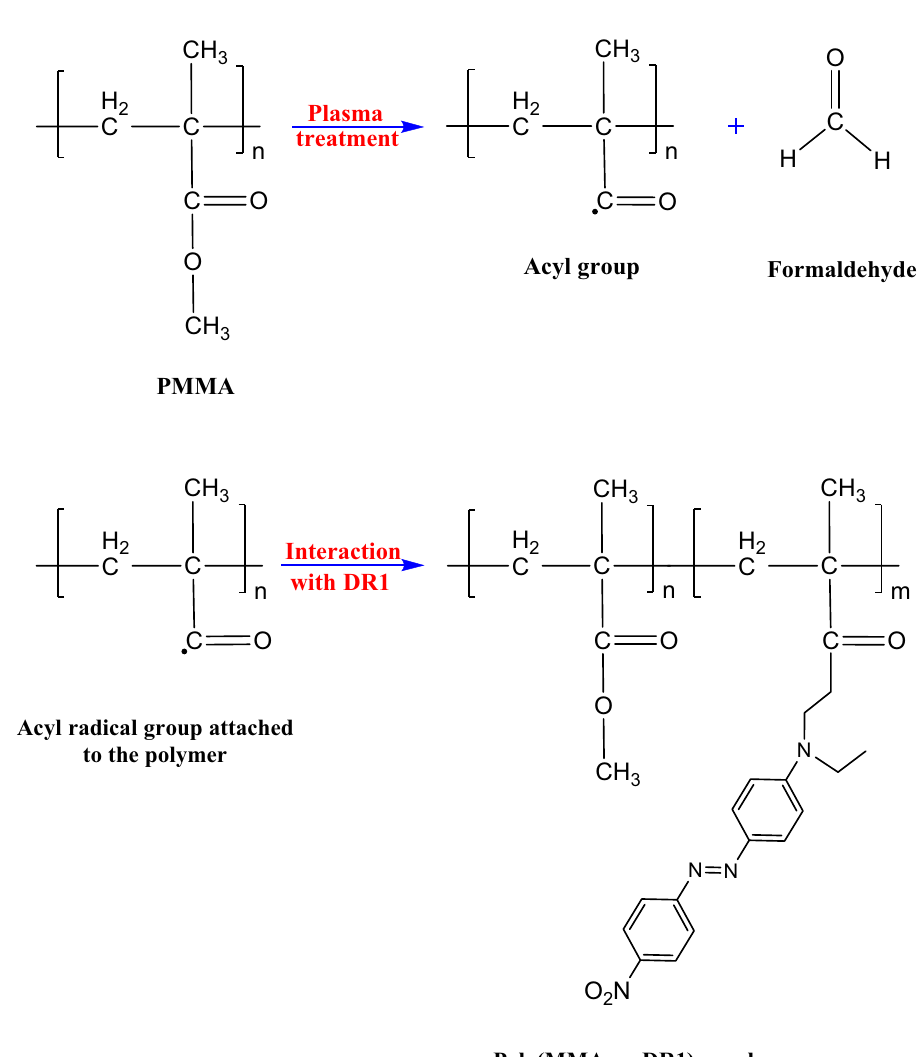
Figure 8. Schematic illustration for chemical changes of PMMA polymer doped with DR1 dye structure due to plasma